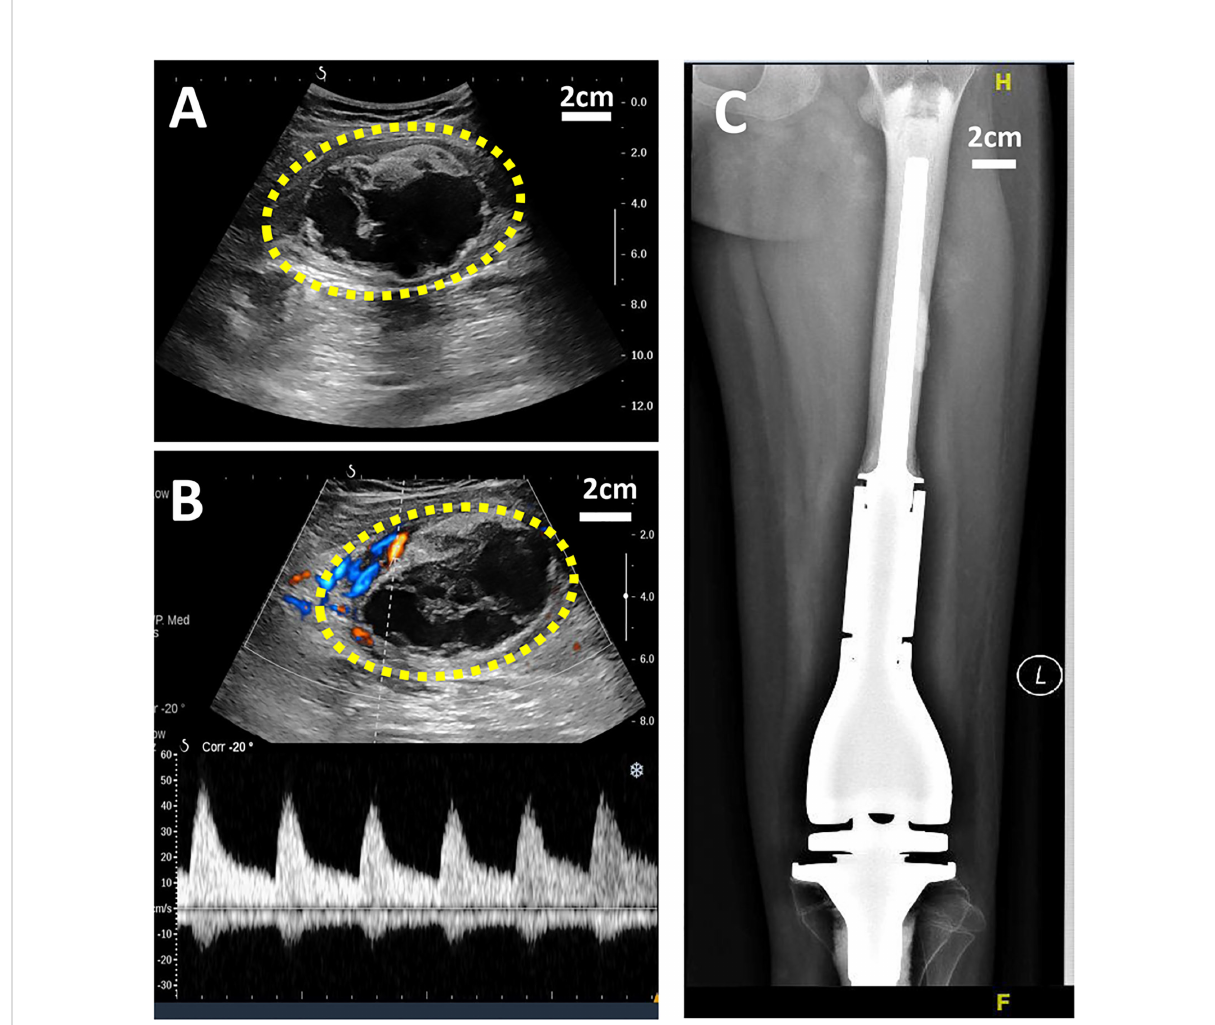
FIGURE 2 US and X-ray images of a 11-year-old girl with OS local recurrence after limb salvage with metal implants. It was easy to see the lesion in US but not in X-ray image. (A) A heterogeneous echogenic mass in the longitudinal plan of US image. (B) Color Doppler and power Doppler US image of the mass. (C) No obvious lesion was found I the X-ray